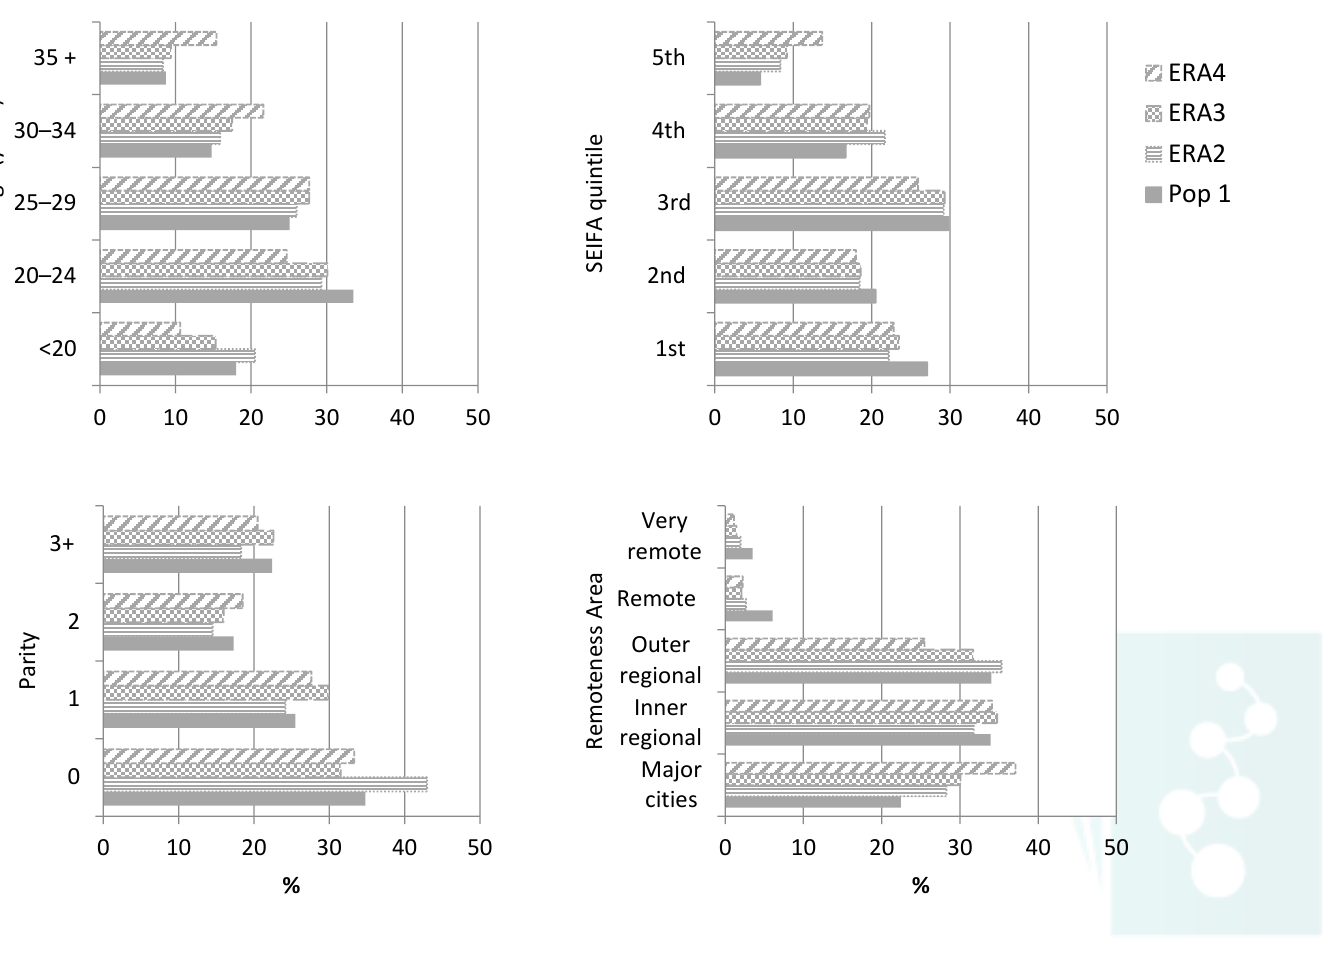
Figure 7: Demographics at the time of birth of mothers who were reported as Aboriginal on the current birth data (Pop 1) or from an enhanced reporting of Aboriginality algorithm (ERA1 – 3) who gave birth to at least one singleton baby in NSW between 2010 and